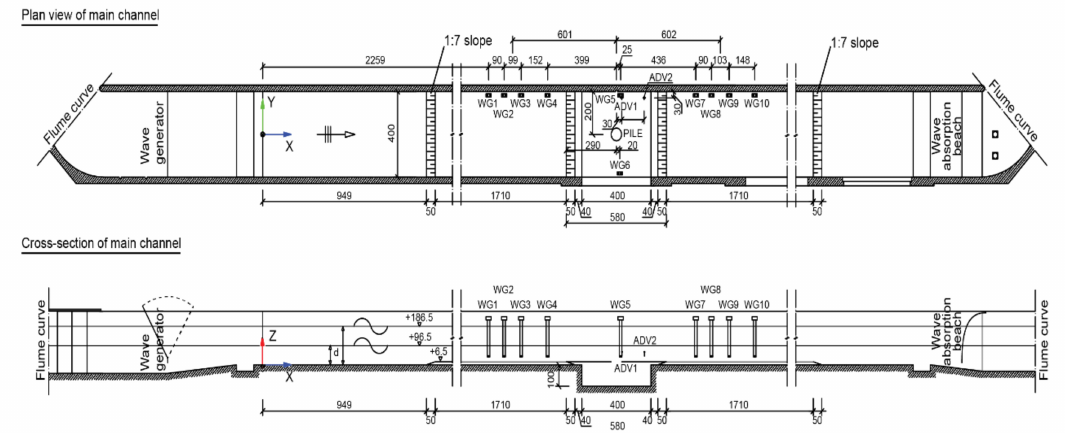
Figure 4. Experimental set-up of PROTEUS project (not to